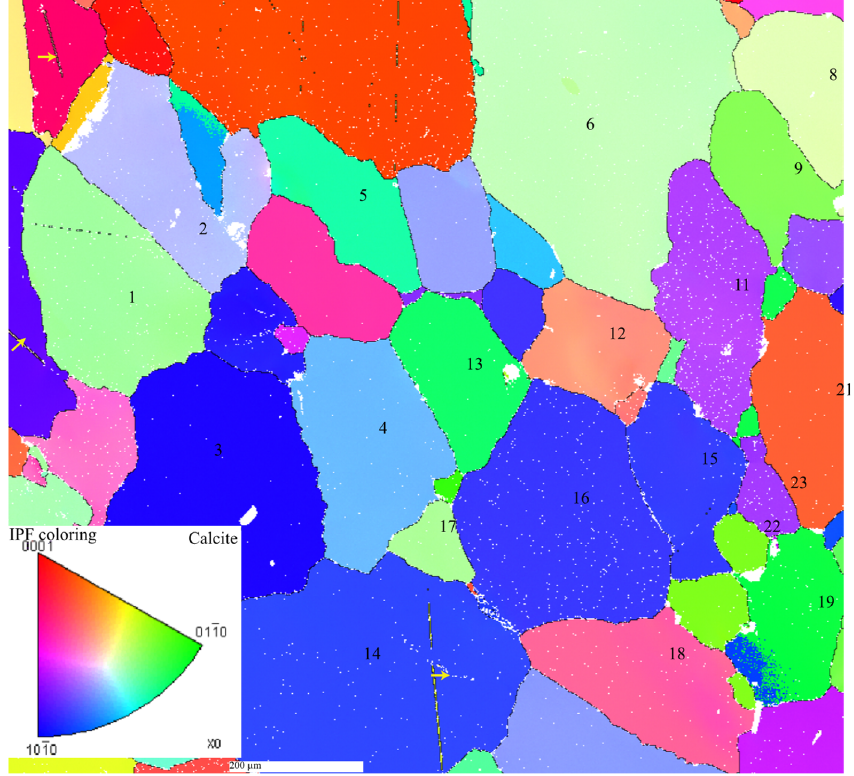
Figure 1. Result of EBSD analysis of a Carrara marble sample. Some twin planes are already distinguished. In this example, the analysis step is quite large, 1.1 µm. The yellow arrows indicate the EBSD-indexed twinned planes.